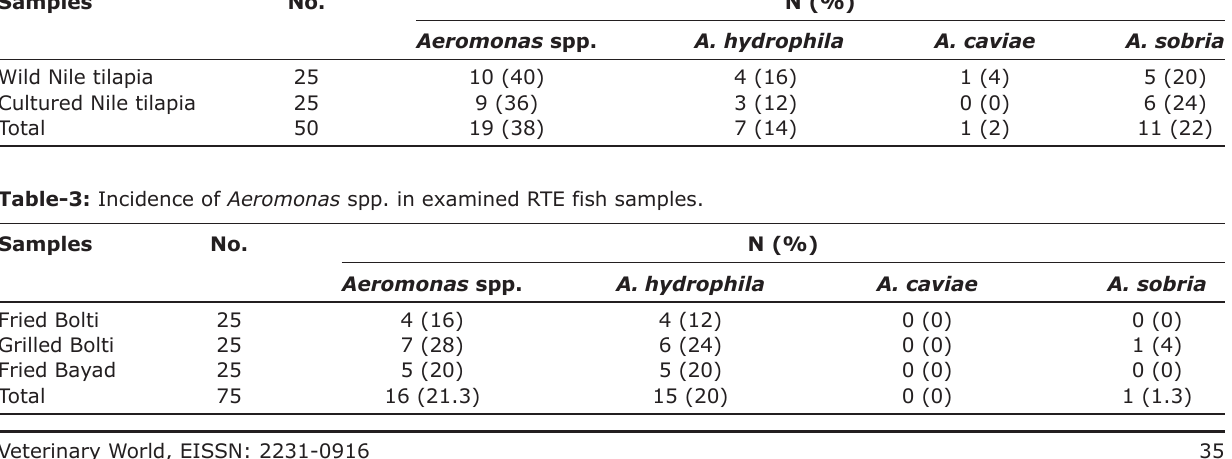
Table-2: Incidence of Aeromonas spp. in examined raw fish samples. Samples No. N (%) Aeromonas spp.